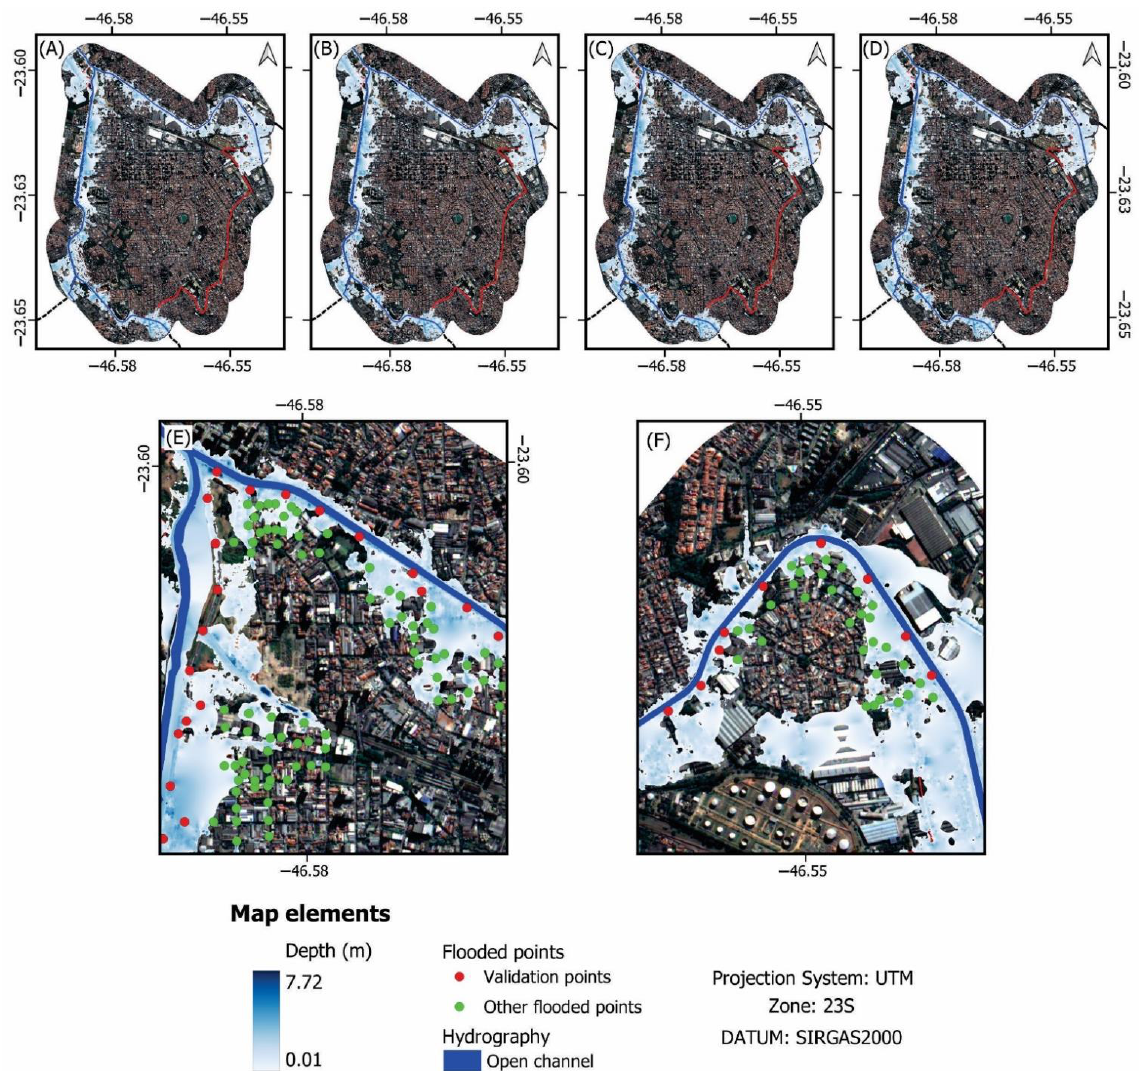
Figure 6. Flood maps generated in HEC-RAS. ( A – D ) represent the simulations with the computing interval of 1, 15, 30, and 60 s, respectively, with the finer DTM (0.50 m). ( E ) is a zoom-in of the confluence of Tamanduateí River and Meninos Brook in the northwestern region of the study area. ( F ) shows a zoom-in of the Tamanduateí River in the northeastern part of the analyzed reach. Red points are used for validation, while the green points represent other flooded points reported by the citizens of São Caetano do Sul. The thick lines in dark blue correspond to the open channels. The different shades of blue in polygonal shape account for the different depths of the flood zones. As for the HEC-RAS simulations with the finer DTM (0.50 m) with refined channel mesh (Figure 7), the simulations with the four different computing intervals (1, 15, 30, and